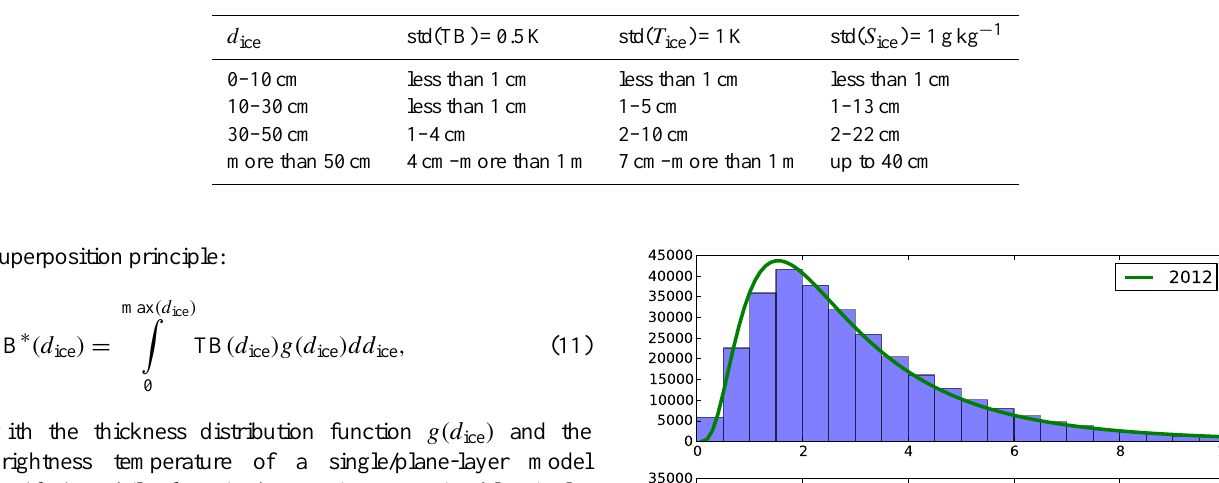
Table 1. Estimated ice thickness uncertainties caused by std(TB), std( T ice ), and std( S ice ).